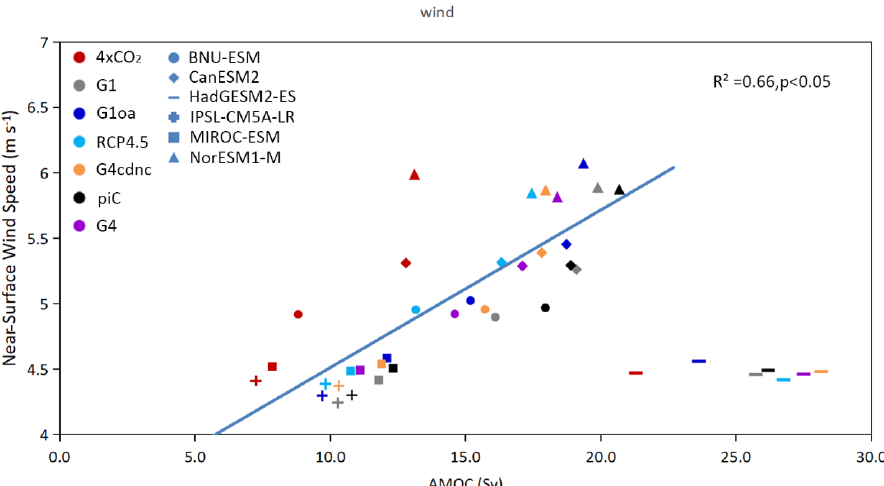
Figure 5. ESM mean of wind speed (ms − 1 ) over the 40-year analysis period in the whole North Atlantic (north of 30 ◦ S). All ESMs except HadGEM2-ES show a high correlation between near-surface wind speed and AMOC intensity. The solid line is the linear regression line of AMOC intensity and wind speed (area average of the whole North Atlantic) over the 40-year analysis period in the five ESMs excluding